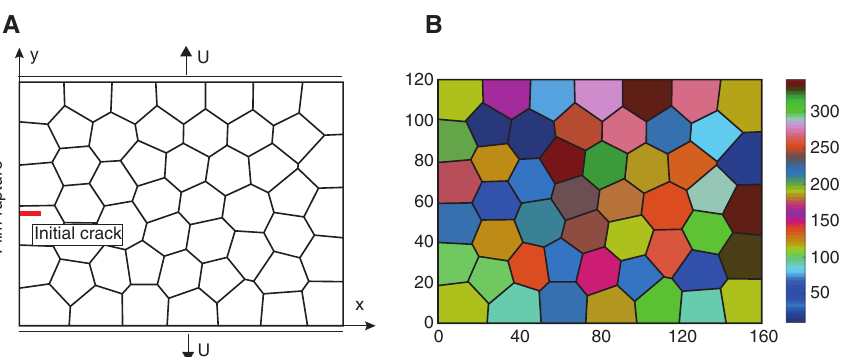
Figure 8: Geometry and boundary conditions for the polycrystalline structure containing 50 grains: (A) grain boundary and loading descrip- tion; (B) angle of the direction of anisotropy.